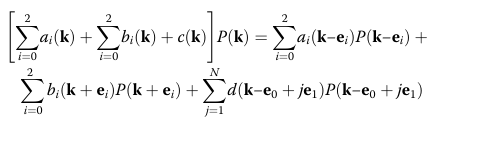
ð 5 Þ Based on these equations and the normalization equa- tion, the state probabilities P ( k ) are obtained. The per- formance metrics of interest in this CRN when the spectrum adaptation strategy is enabled are as follows. Let P P ð Þ , P S ð Þ , and P S ð Þ represent, respectively, the new call b b v b d Us, and S Us, while P S ð Þ blocking probabilities of PUs, S v d ft v represents the forced call termination probability of S Us. v (cid:1) Blocking probability for PUs, which occurs when the total number of channels of the system are being used by